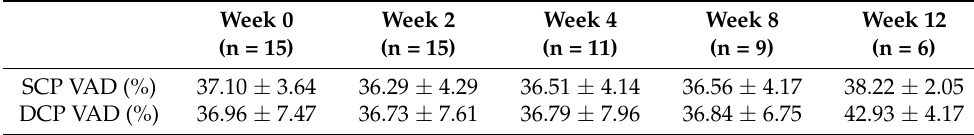
Table 5. Comparison of SCP and DCP VAD before initiation of treatment and during